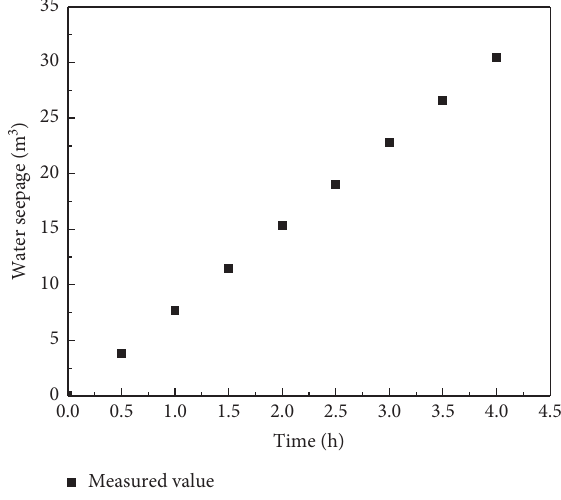
Figure 8: Measured value of water